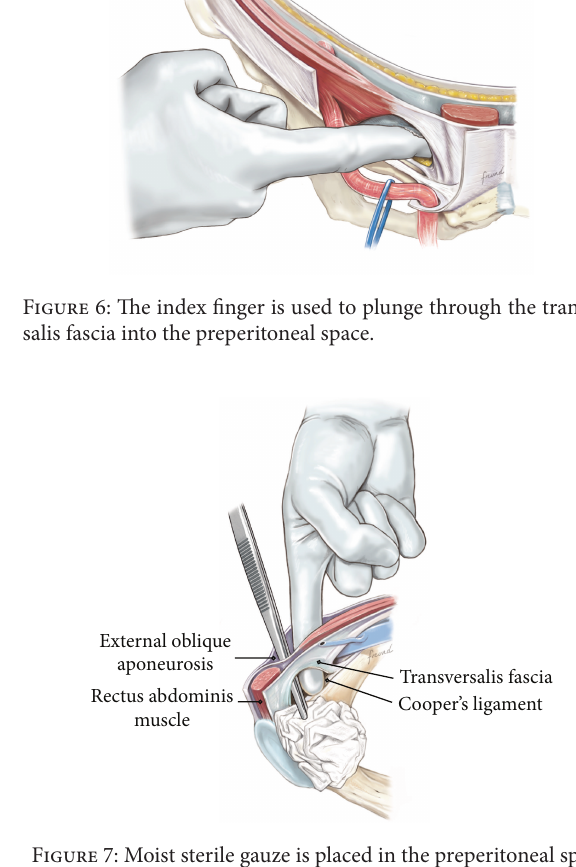
Figure 7: Moist sterile gauze is placed in the preperitoneal